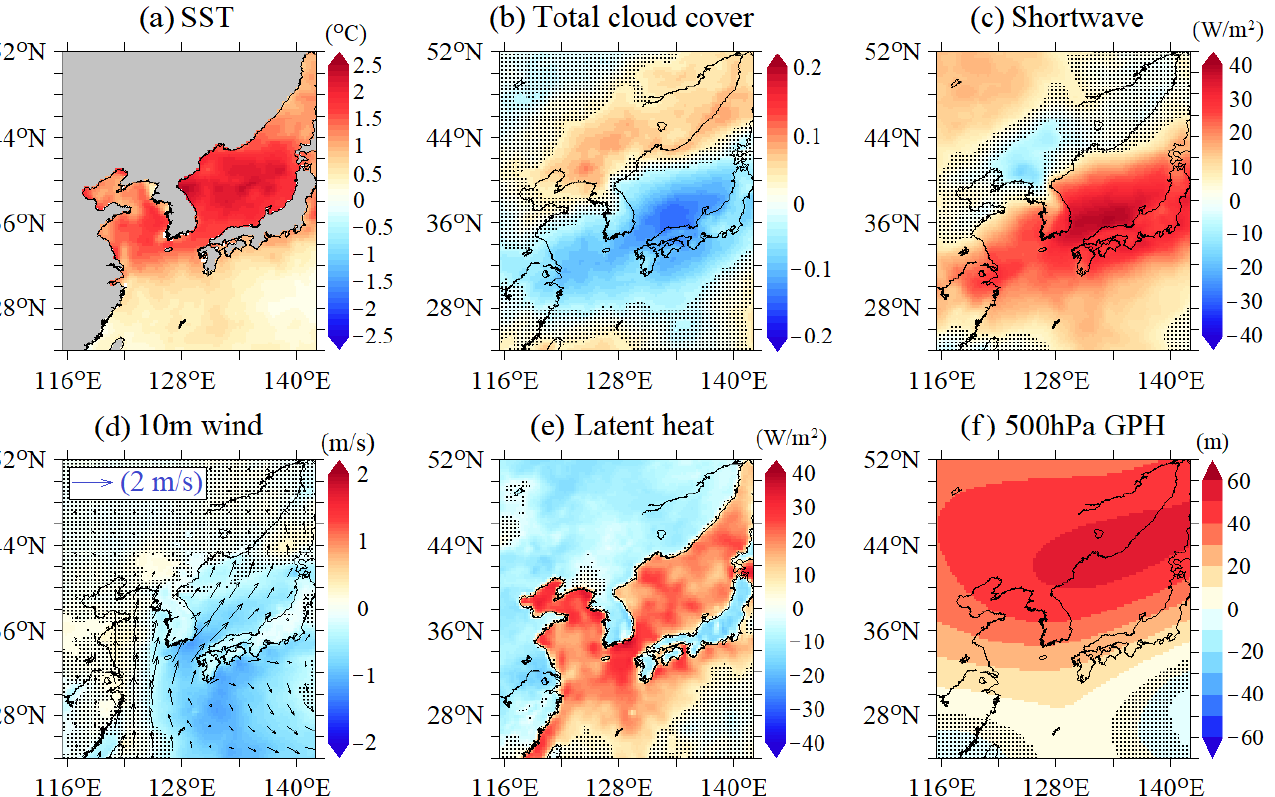
Figure 6. Composite differences during the top third (strong) and the bottom third (weak) MHW characteristics (duration, coverage, mean intensity) in summer (strong–weak). ( a ) Sea surface temperature, ( b ) total cloud cover, ( c ) shortwave radiation, ( d ) 10 m wind speed and direction, ( e ) latent heat flux (downward positive), and ( f ) 500 hPa geopotential height. The dotted areas indicate insignificant values at a 95% confidence level using Student t -test ( p -value > 0.05).